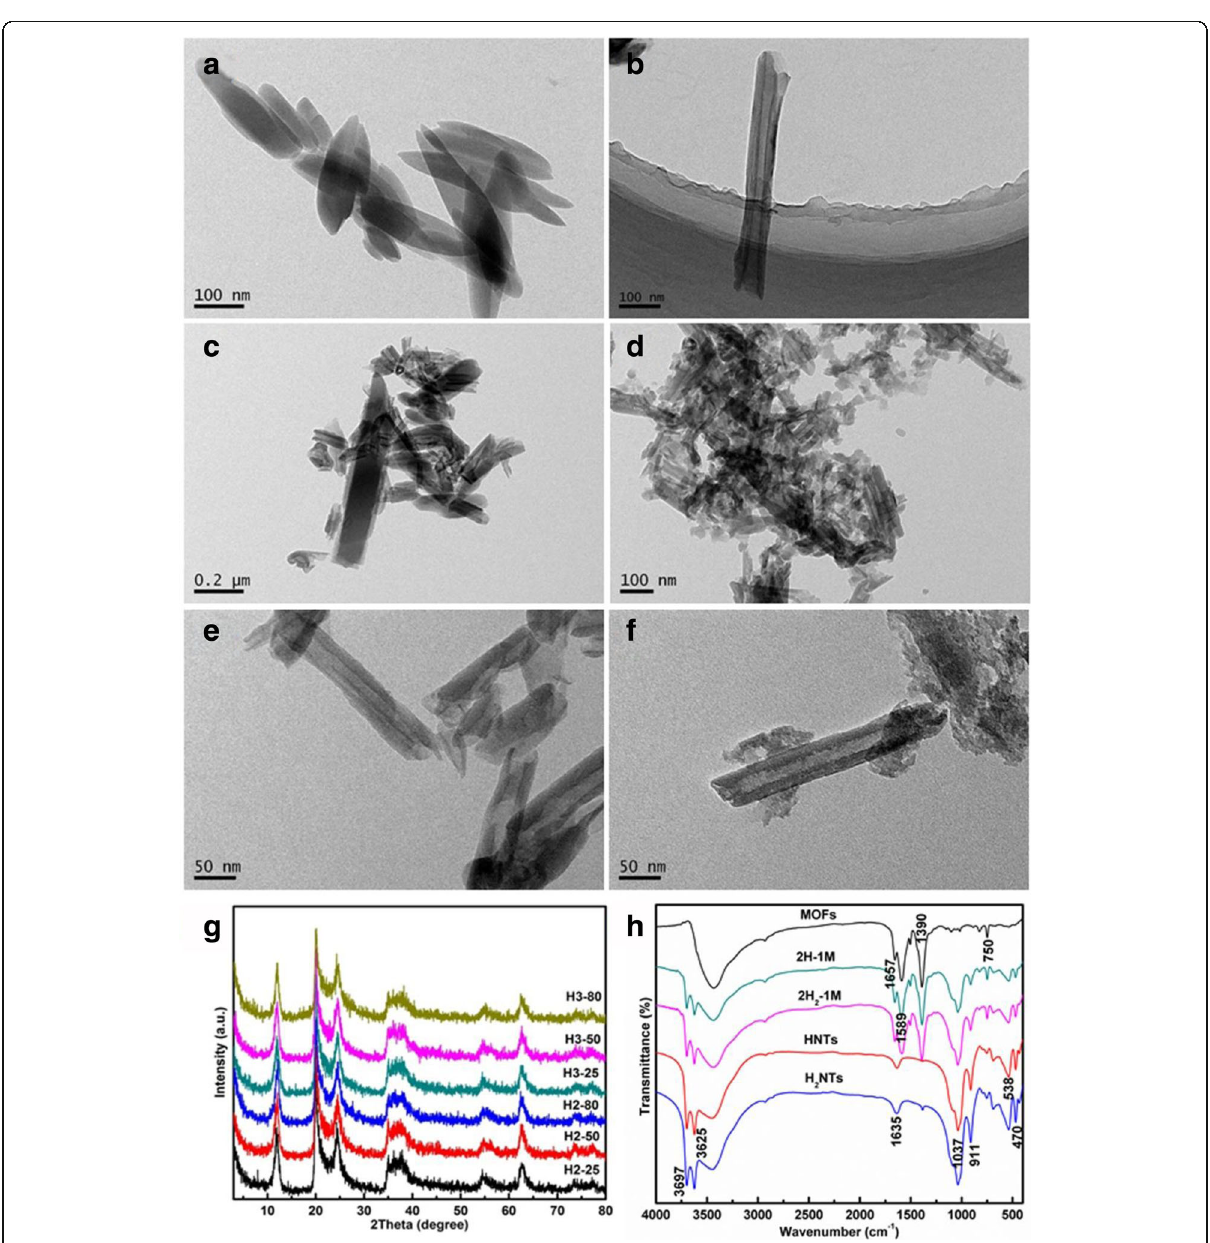
Fig. 1 TEM image of a MOFs-Zn, b HNT, c 2H-1M, d 2H 2 -1M, e H2-25, and f H3-80 samples. g XRD patterns of acid-treated HNTs under different conditions. h FTIR spectra of MOFs-Zn, HNTs, H 2 NTs, and the